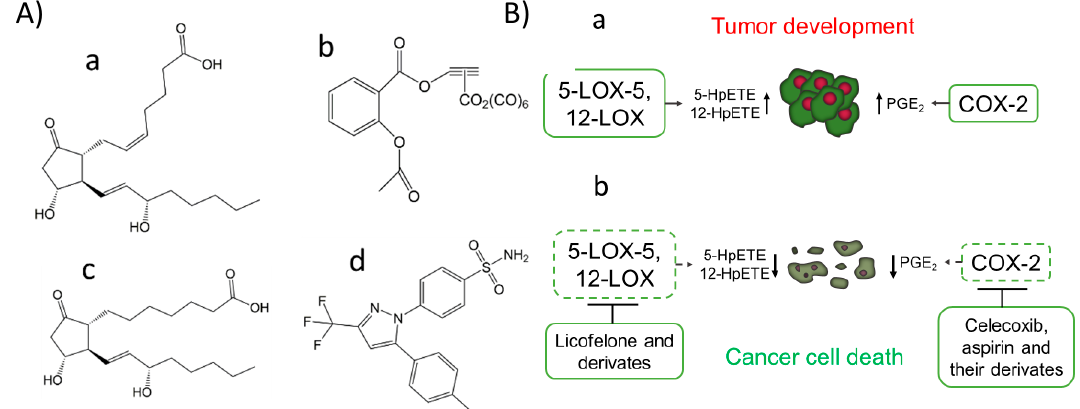
Figure 1. COX-2 inhibitors, PGE 1, and PGE 2 chemical structure ( A ). The prostaglandin E 2 (PGE 2 ) (pro-cancer) ( a ), the aspirin derivate named [2-acetoxy-(2-propynyl)benzoate]hexacarbonyldicobalt (Co-ASS) ( b ), the prostaglandin E 1 (PGE 1 ) (anticancer) ( c ) and the COX-2 selective inhibitor named celecoxib, ( p -(5- p -Tolyl-3-(trifluoromethyl) pyrazol-1-yl)benzenesulfonamide) ( d ). Expression of COX-2, 5-LOX, and 12-LOX in cancer and the effect of inhibitors against these targets ( B ). Activation of 5-LOX-5, 12-LOX, and COX-2 has been reported in the development and progress of tumors from different tissues associated with the production of specific lipid peroxides and metabolites, such as PGE 2 ( a ). Some inhibitors of these LOX isoforms and COX-2 have emerged as potential therapeutical agents for cancer treatment, modulating the production of previously commented metabolites and by induction of cancer cell death ( b ).